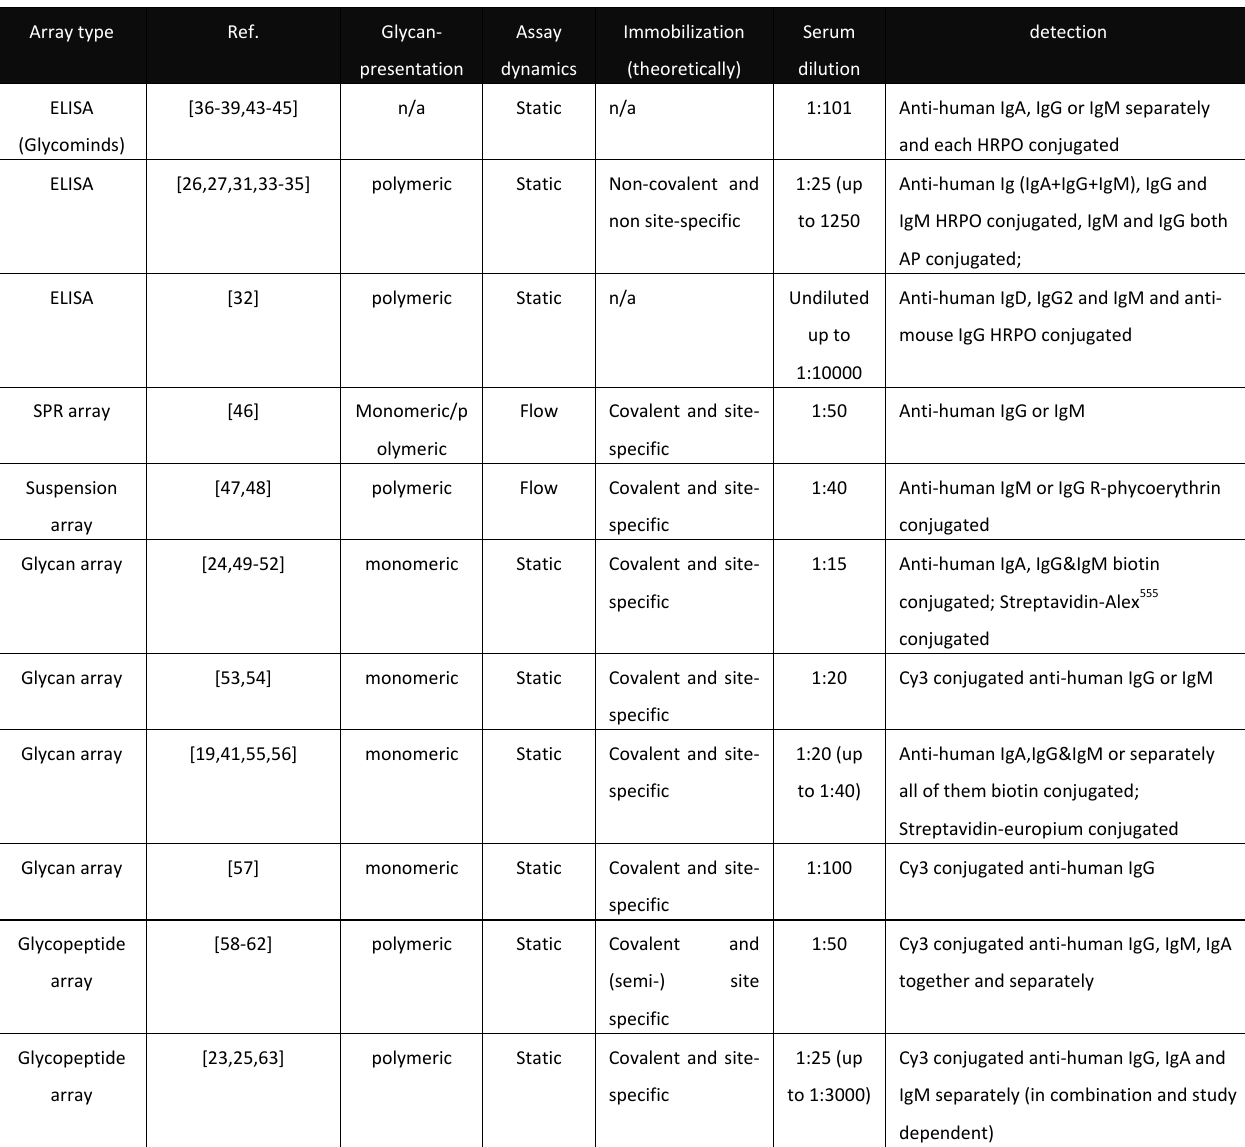
Table 1. Characteristics of major glycan-based array